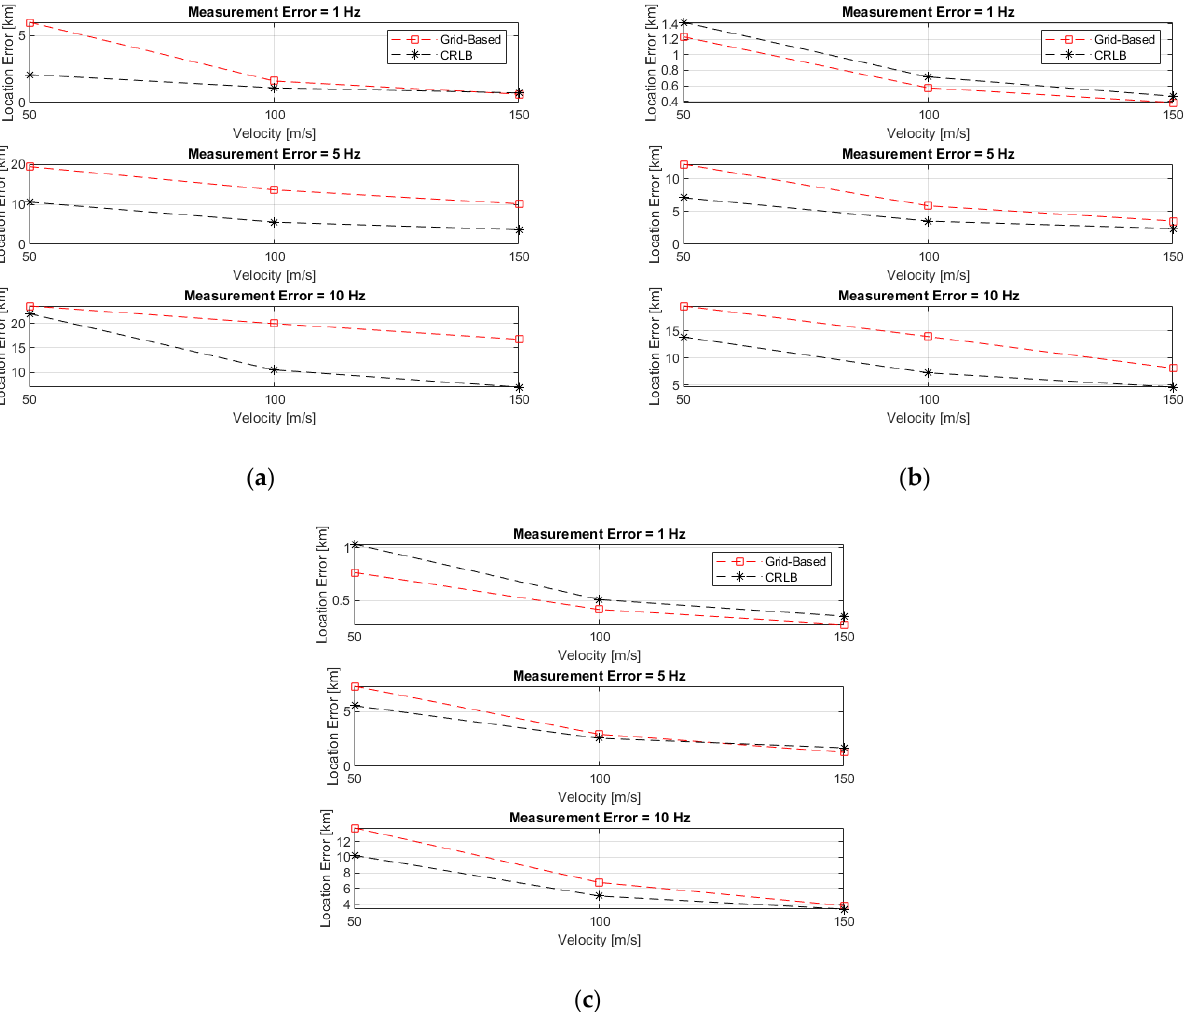
Figure 5. Grid-based solution accuracy with a grid resolution of 100 m and the corresponding CRLB, with various baselines of: ( a ) 10 km; ( b ) 15 km; ( c ) 20 km. Table 1. Solution accuracies and corresponding Cramér–Rao lower bound (CRLB) with a baseline of 20 km.